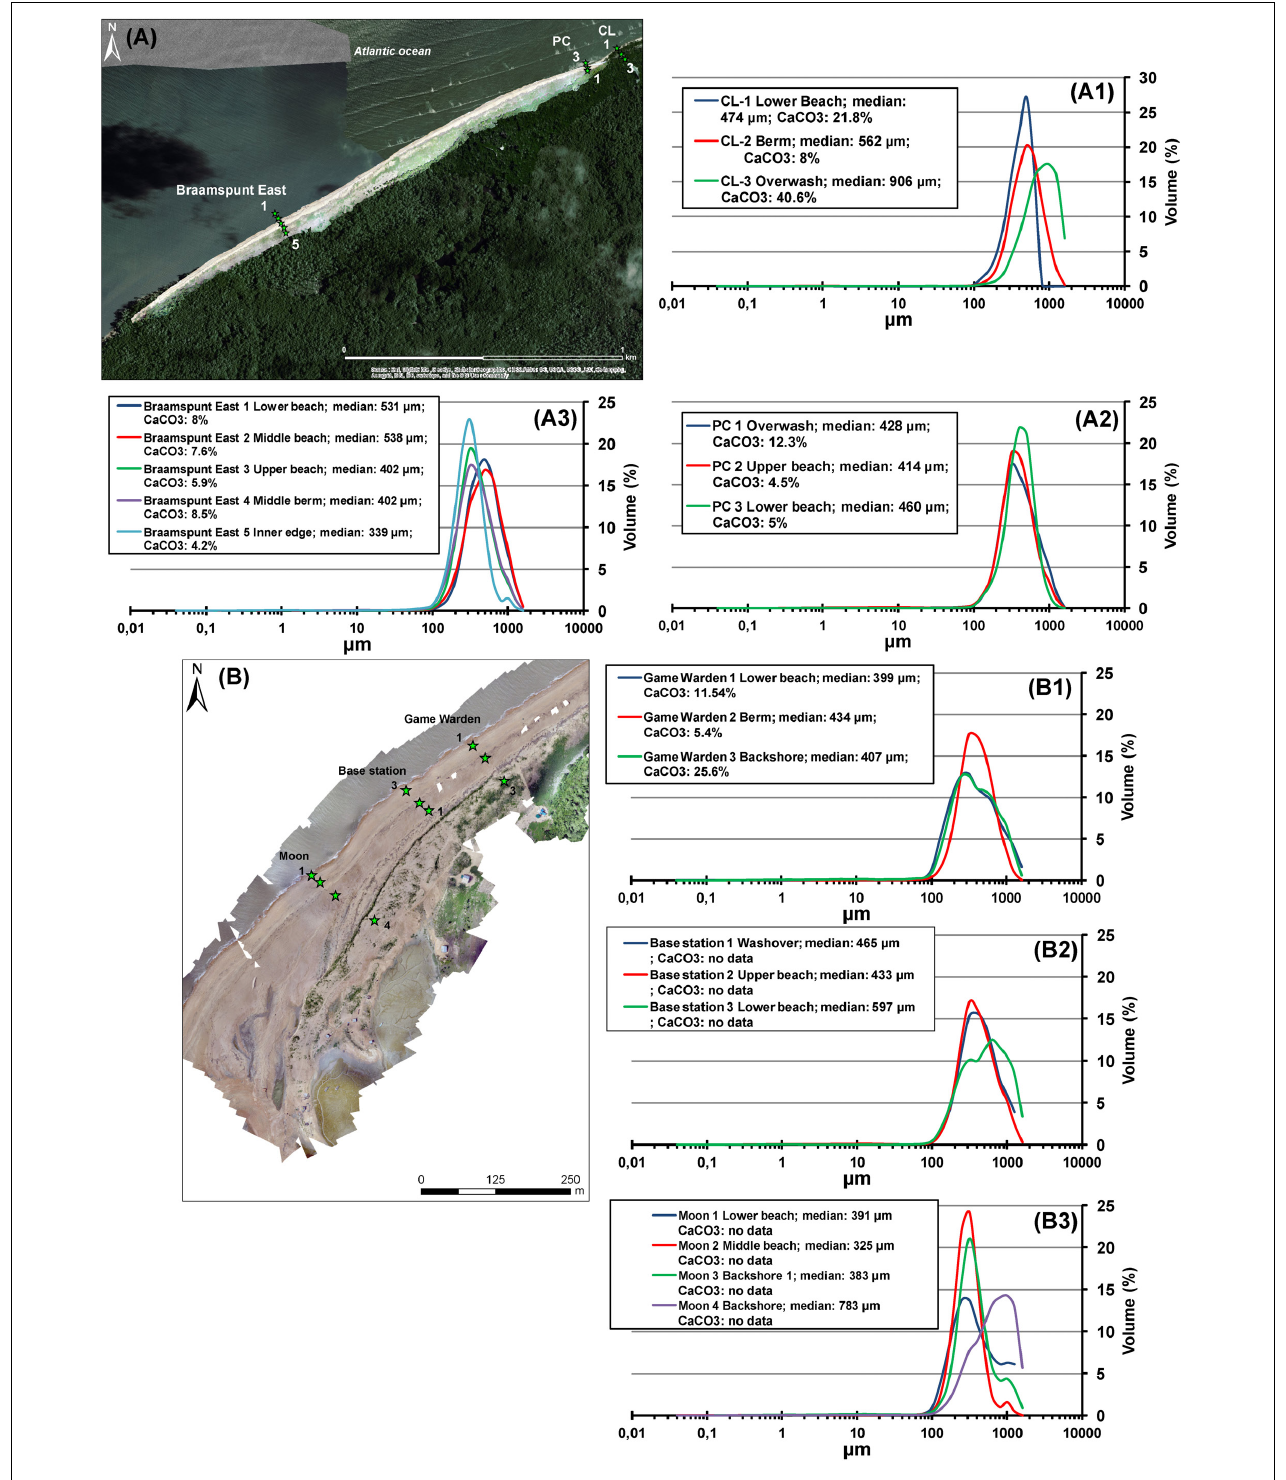
FIGURE 9 | Grain-size characteristics of Braamspunt beach determined by laser analysis, and percentage of carbonates. Satellite image (A) and drone-derived orthophoto (B) show sample locations. The grain-size curves (A1–A3,B1–B3) show a clear concentration around median values of 400 to 560 µ m, indicating well-sorted medium sand dominated by